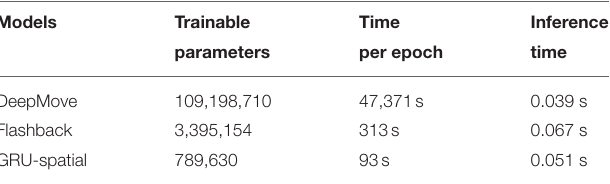
TABLE 5 | Model size, training time, and inference time for the three centralized